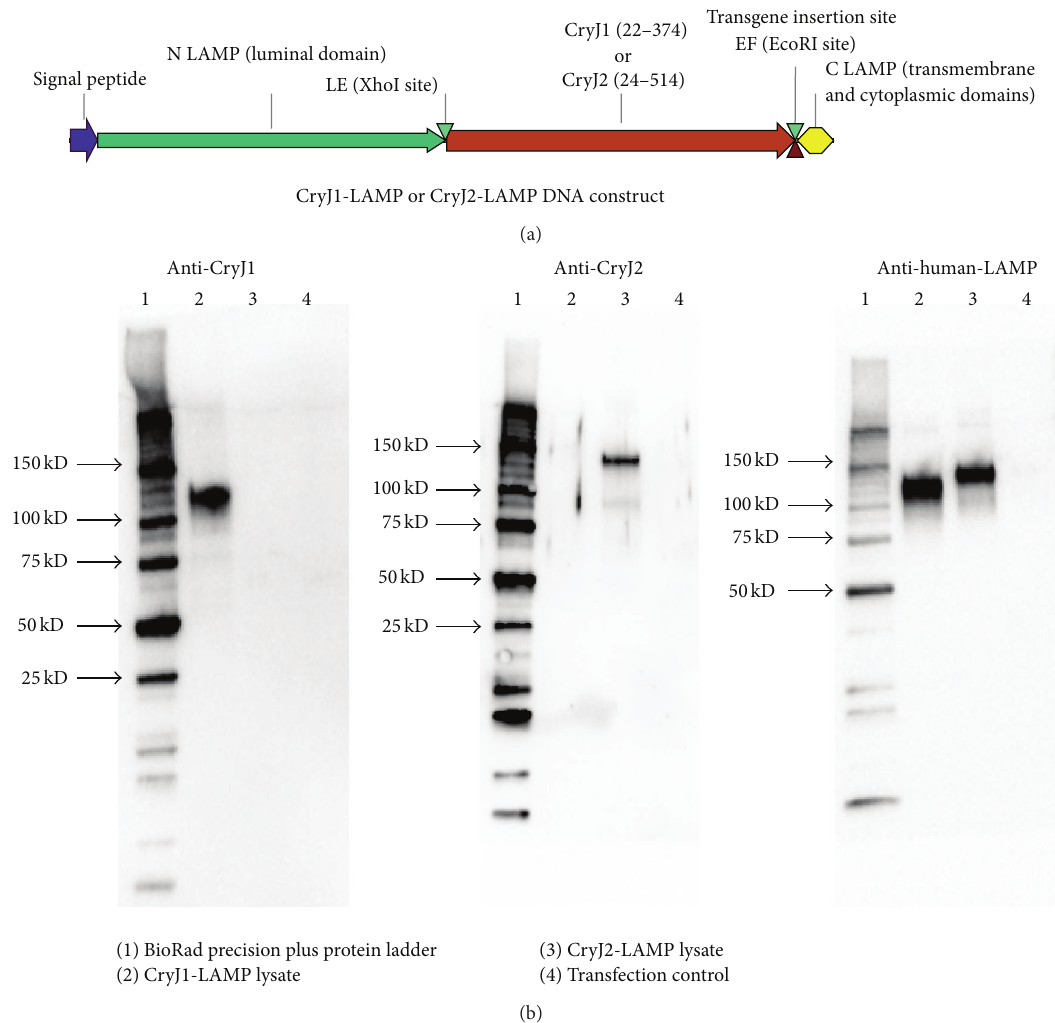
Figure 1: CryJ-LAMP DNA construct and expression in vitro . (a) Plasmid construction of LAMP Vaccine. CryJ1-LAMP and CryJ2-LAMP plasmids were generated by inserting synthetic CryJ1 or CryJ2 gene into the N LAMP-C LAMP gene to create N LAMP-CryJ1-C LAMP or N LAMP-CryJ2-C LAMP. (b) 293T cells were transfected with CryJ1-LAMP or CryJ2-LAMP. Transfection reagents Opti-MEM and Lipofectamine 2000 solution only were used as a transfection control. Cell lysates were examined for expression of CryJ1-LAMP or CryJ2- LAMP by using antibodies against CryJ1 (left), CryJ2 (middle), or human-LAMP (right),